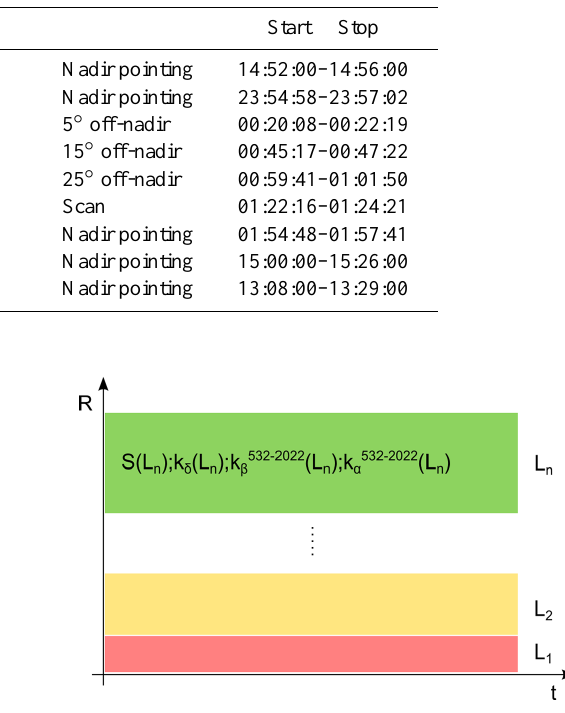
Figure 8. Scheme of the atmospheric layers with different aerosol (L n ) and types (L n ) , where S 532 (L n ) is the lidar ratio, k 532 → 2022 β k 532 → 2022 α (L n ) are the conversion factor of the backscatter and ex- tinction coefficient, respectively, and k δ (L n ) the system depolariza- tion response corresponding to the aerosol type. Within each layer, the aerosol properties are assumed to be